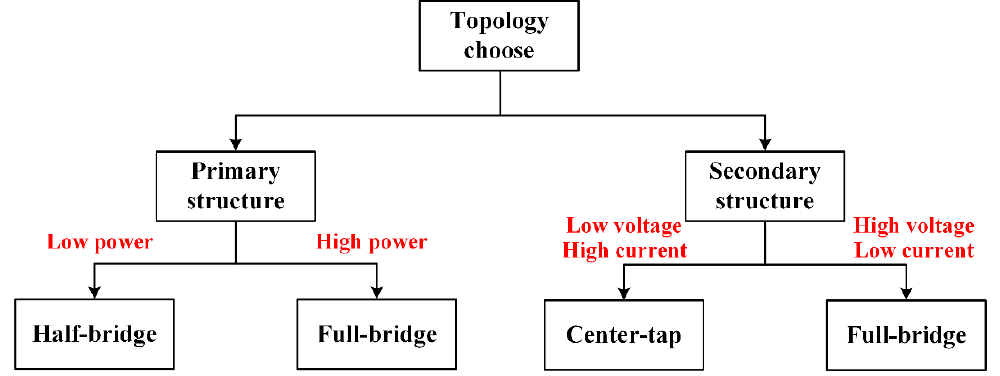
Figure 1. Architecture selection diagram.